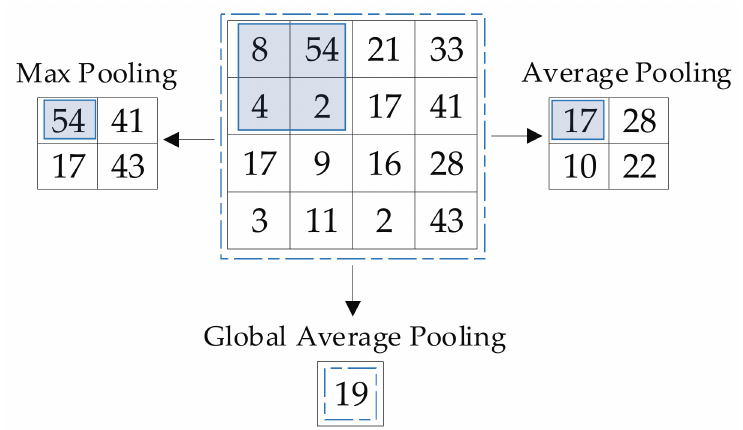
Figure 5. Pooling